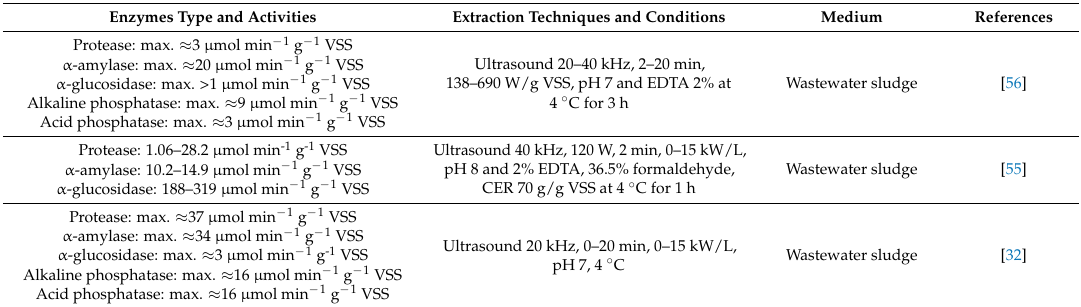
Table 3. Representative studies for enzymes extraction from WAS-derived